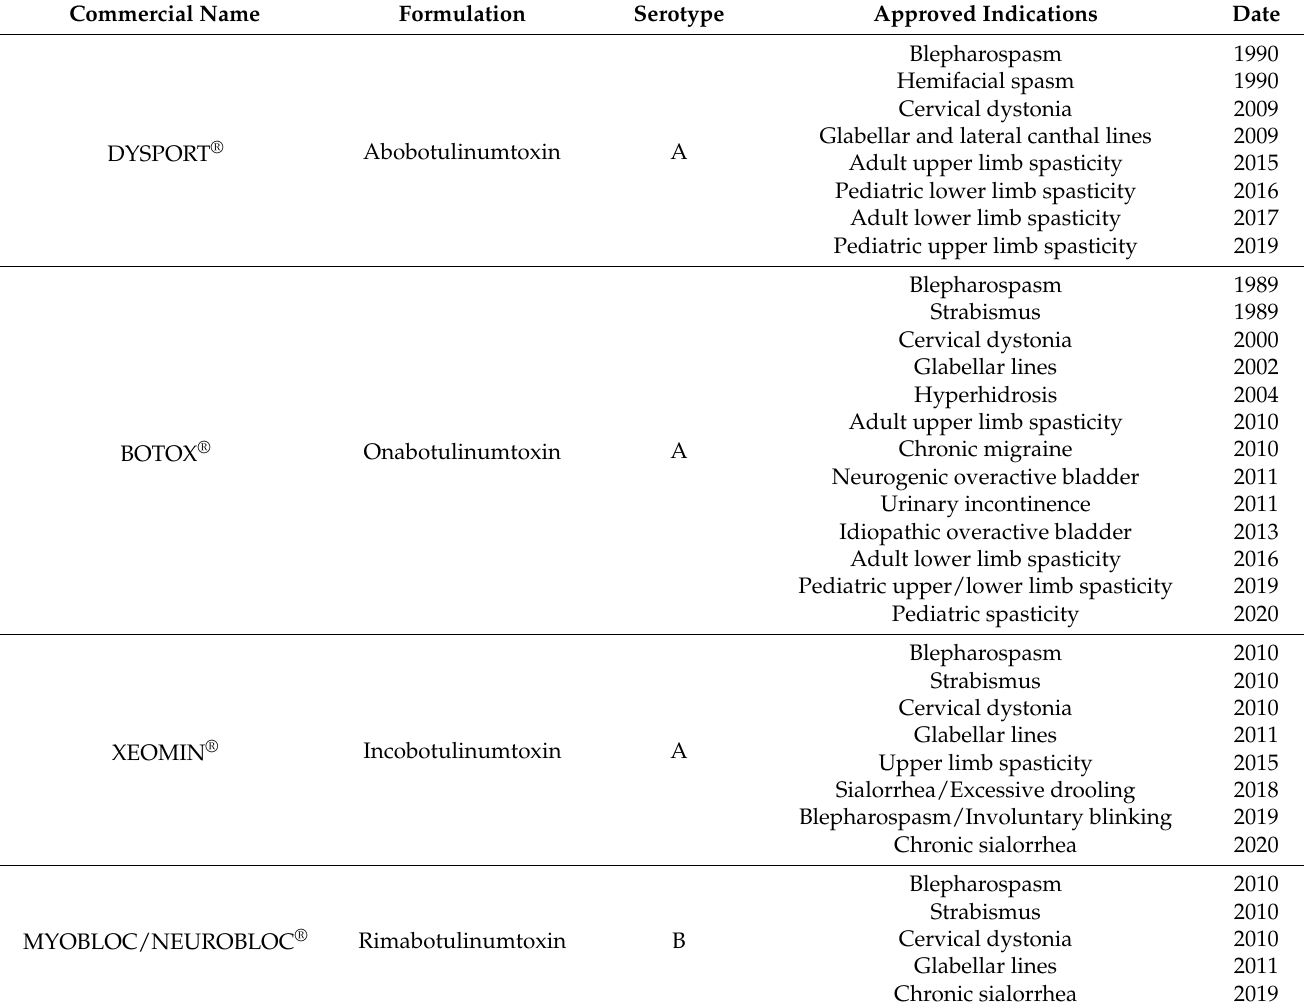
Table 2. BoNTs administration authorities-approved therapeutic